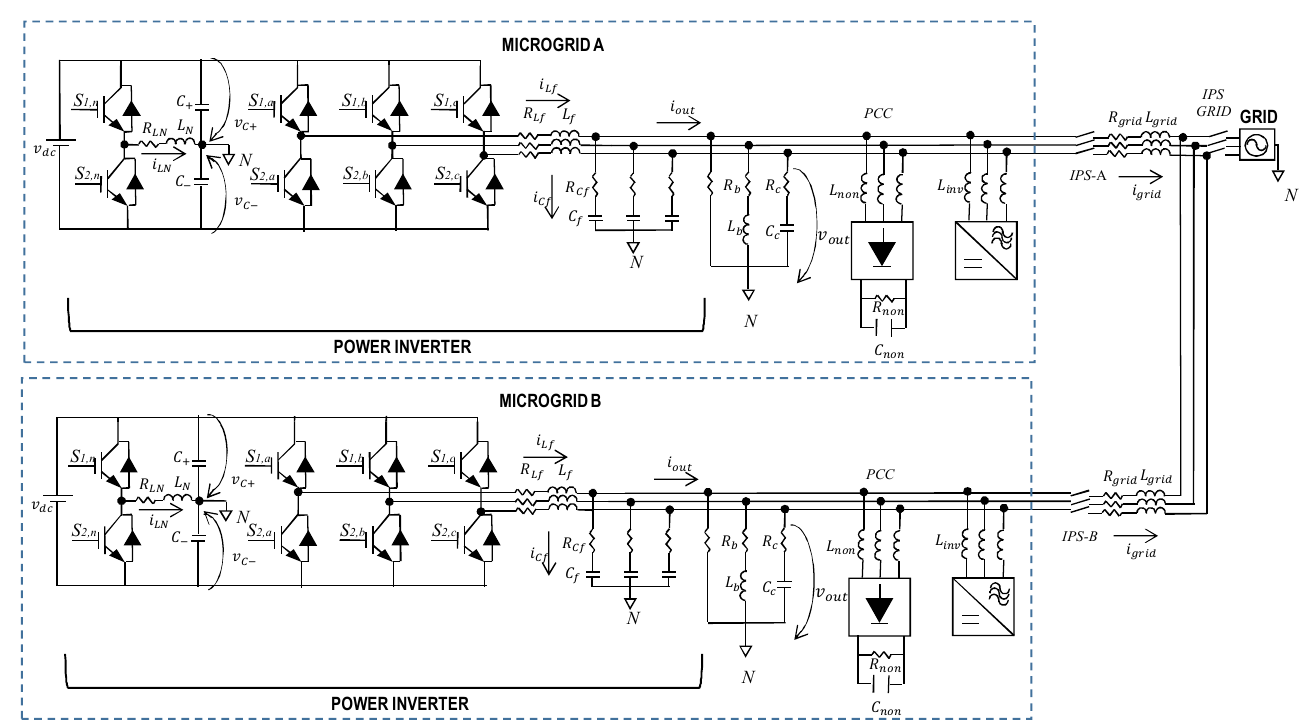
Figure 1. Interconnected microgrids object of study.